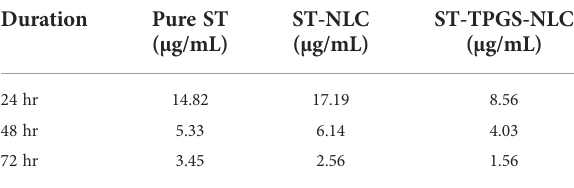
TABLE 4 IC 50 of pure ST, ST-NLC, and ST-TPGS-NLC on cell viability of SW48 Cells PTEN cell line using MTT assay after 24 th hr and 48 th hr. Duration